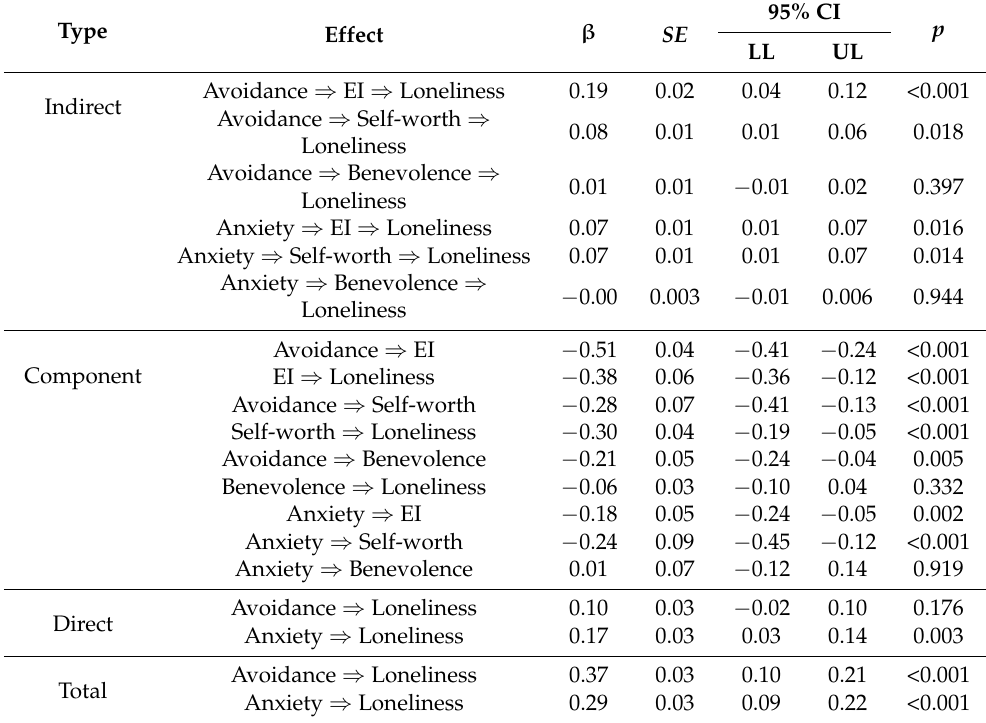
Table 6. Mediation analysis for Study